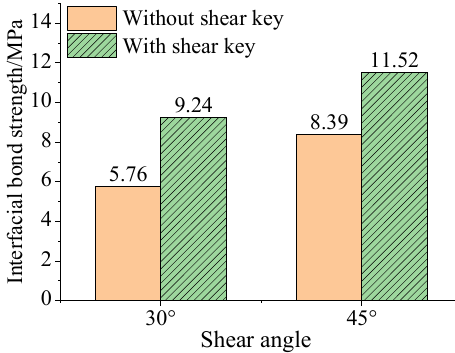
Figure 7. Influence of shear key on interfacial bond strength.